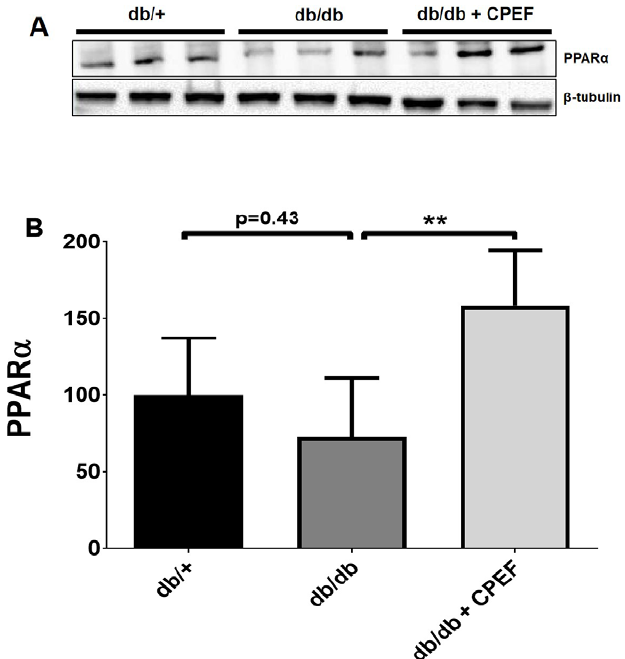
Figure 3. Treatment with CPEF increases hepatic PPAR α expression in db/db mice. ( A ) Representative western blots of PPAR α and β -tubulin in the liver of db/+ mice, db/db mice, and db/db mice treated with CPEF. ( B ) Quantitative protein expression of PPARα. Mice were treated with the vehicle control or CPEF ( 351.5 mg/kg) daily for 28 days. Protein expression was normalised to β -tubulin and data are expressed as a percentage relative to db/+ mice, which was set at 100%. Data are represented as the mean ± SD ( n = 6). Statistical significance between the groups is denoted as ** p < 0.01 compared to the db/db control group 2.4. Effect of CPEF Treatment on Lipid Peroxidation and Protein Oxidation Lipid peroxidation levels tend to be lower in CPEF-treated db/db mice compared to untreated db/db control mice, given a 1.6-fold lower hepatic MDA content (0.43 ± 0.22 vs. 0.68 ± 0.22 µmol/mg, p = 0.07) (Figure 4). Lipid peroxidation could not be quantified in the brown adipose tissue due to the limited amount of tissue sample available. Protein car- bonylation in the brown adipose tissue was 1.2-fold lower in CPEF-treated db/db mice compared to untreated db/db control mice (0.29 ± 0.07 vs. 0.36 ± 0.05 nmol/mg, p = 0.06) (Figure 5A), whereas no differences were observed in the liver ( p = 0.59) (Figure 5B).